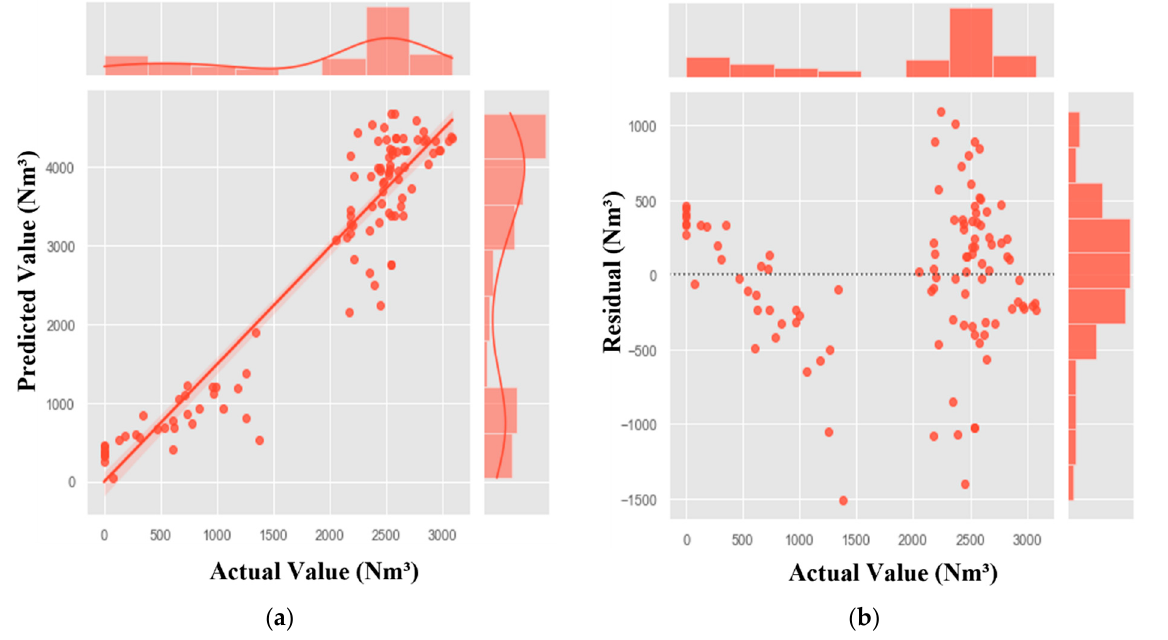
Figure 12. Jointplot of the MLP-based LNG Usage Prediction Model: ( a ) Regplot and ( b ) Residplot.